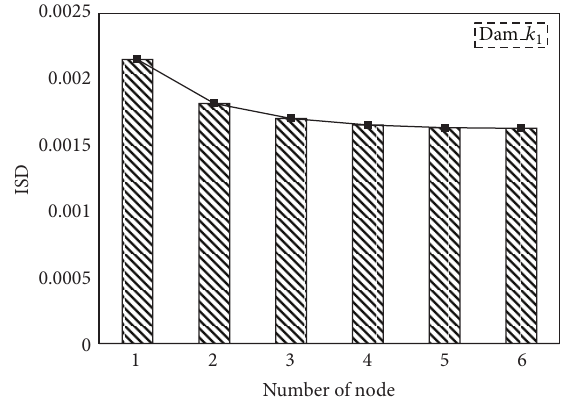
Figure 3: The in situ damage index, ISD 𝑖 : damaged on 1st